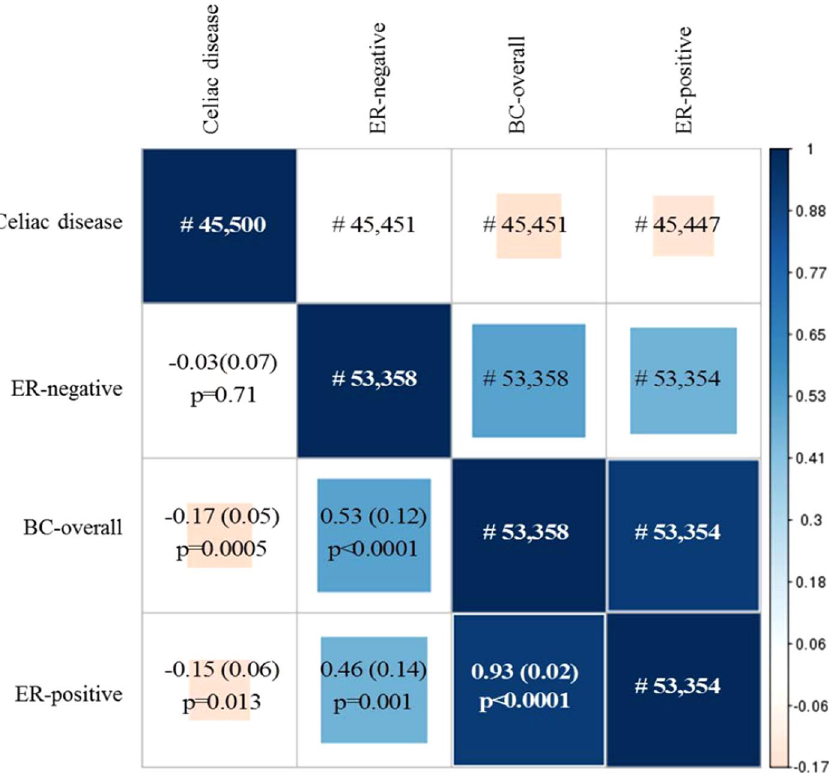
Figure 1. Genetic correlation using LD score regression. Plot is based on LDSC regression coefficients for each comparison pair (e.g. BC vs CD, BC ER-negative Vs CD, BC ER-positive Vs CD, etc.). Subdiagonal cells indicate the respective correlation coefficient and (standard error). Square size and color are scaled according to the correlation coefficient r . Traits are paired using hierarchical cluster analysis. # Number of overlapping SNPs included in the LDSC regression.